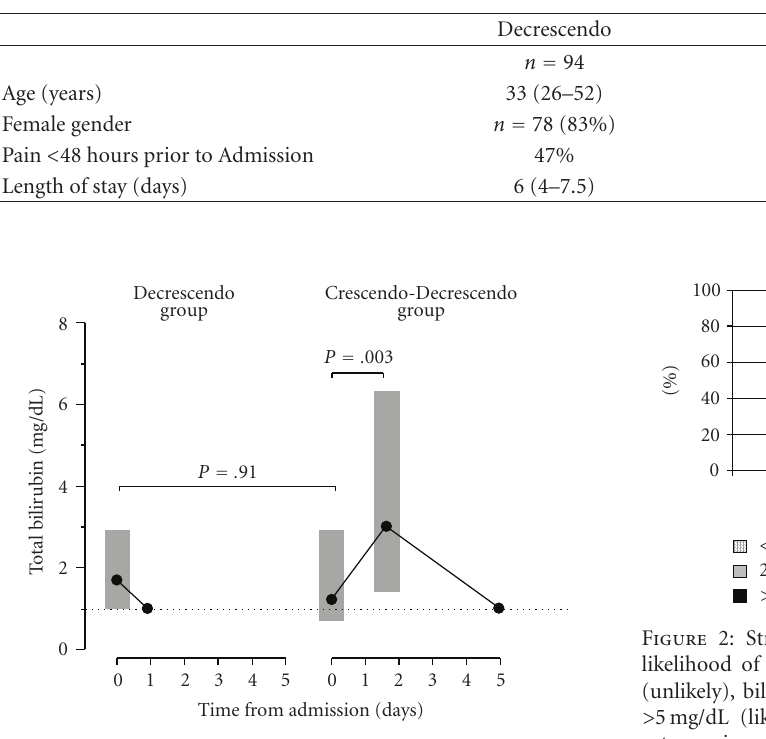
Table 1: Patient characteristics in the Decrescendo and Crescendo-Decrescendo groups.